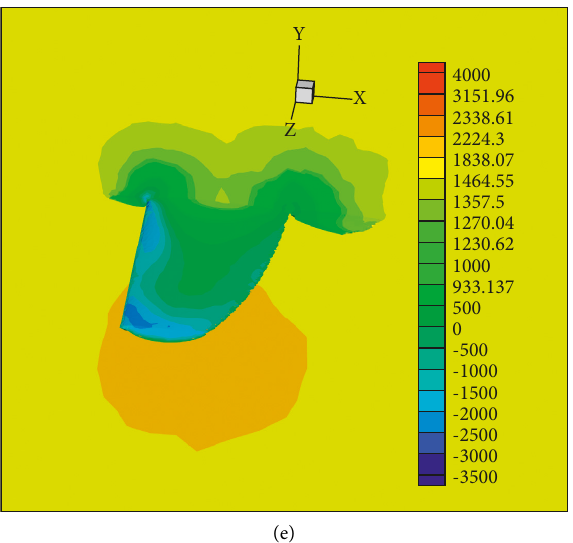
Figure 8: Pressure contours of the flapping wing robot. (a) and (b): the lower and upper surfaces of the robot in the steady state; (c): 3D view along the symmetrical plane in the steady state; (d): 3D view in the transient state when the wing flaps upwards; (e): 3D view in the transient state when the wing flaps